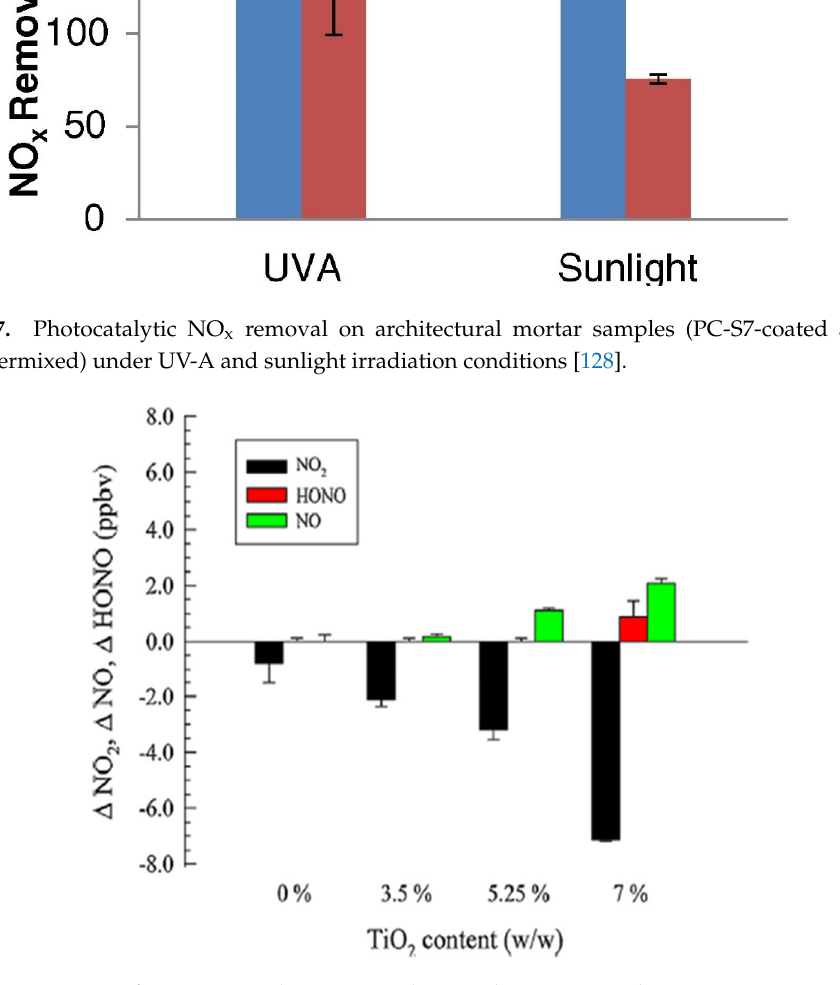
Figure 7. Photocatalytic NO x removal on architectural mortar samples (PC-S7-coated and 5% TiO 2 - intermixed) under UV-A and sunlight irradiation conditions [128] .